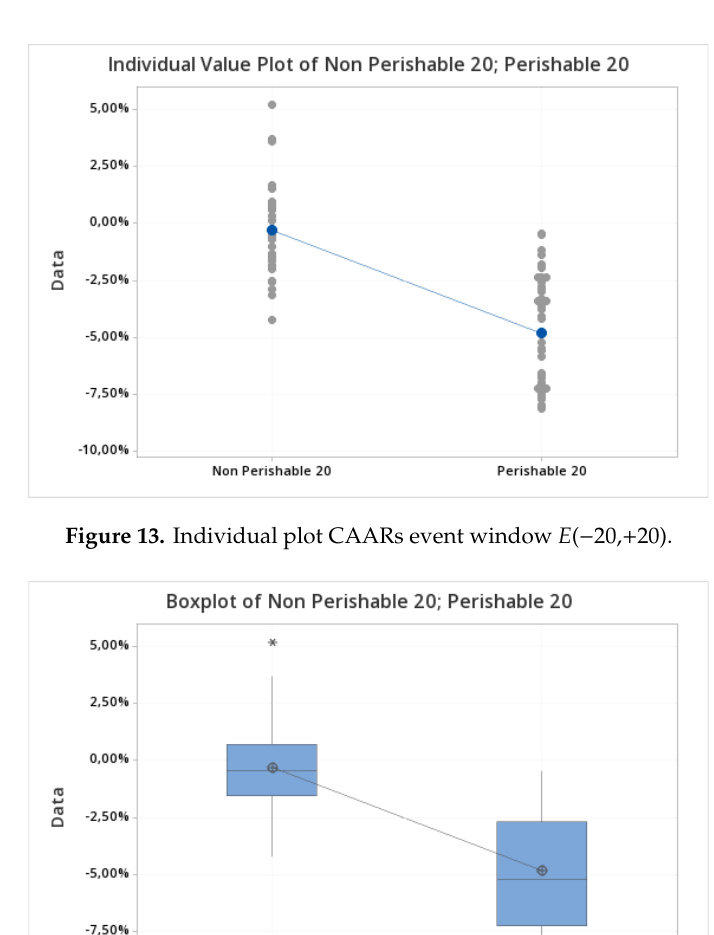
Figure 12. Boxplot CAARs event window E (− 5,+5) .